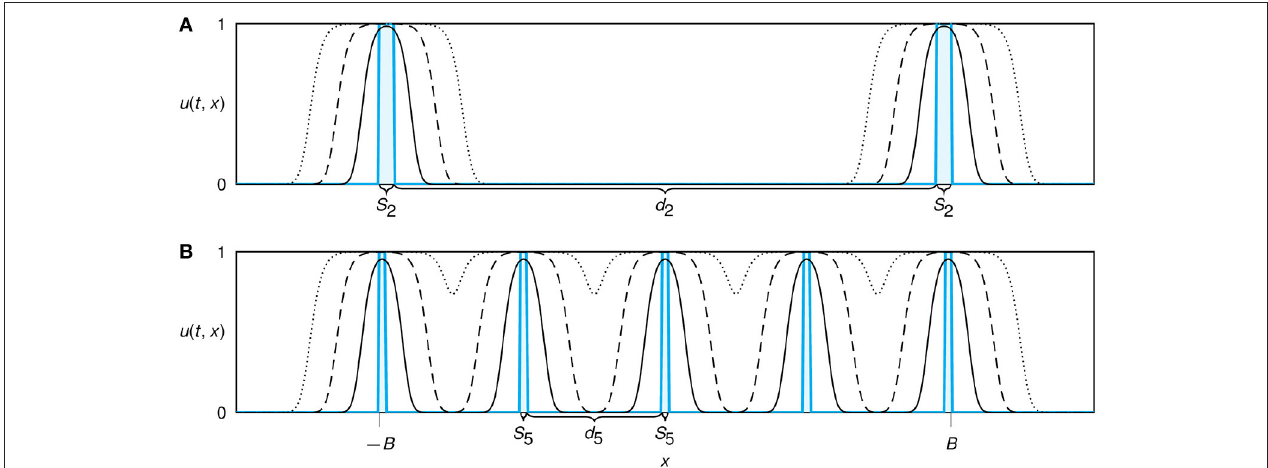
FIGURE 1 | Sketch of the modeled restoration design for a multi-patch set up of n in cyan. Patches are distributed equidistantly with inter-patch distance d n . With increasing number of patches we reduce both the patch width S n , keeping the initial total population size nS n constant, and the distances between the patches d n , ensuring that edges of the outer patches remain at the same locations configurations. The solid, dashed, and dotted lines show simulated spatial profiles of the growing and expanding population at subsequent time